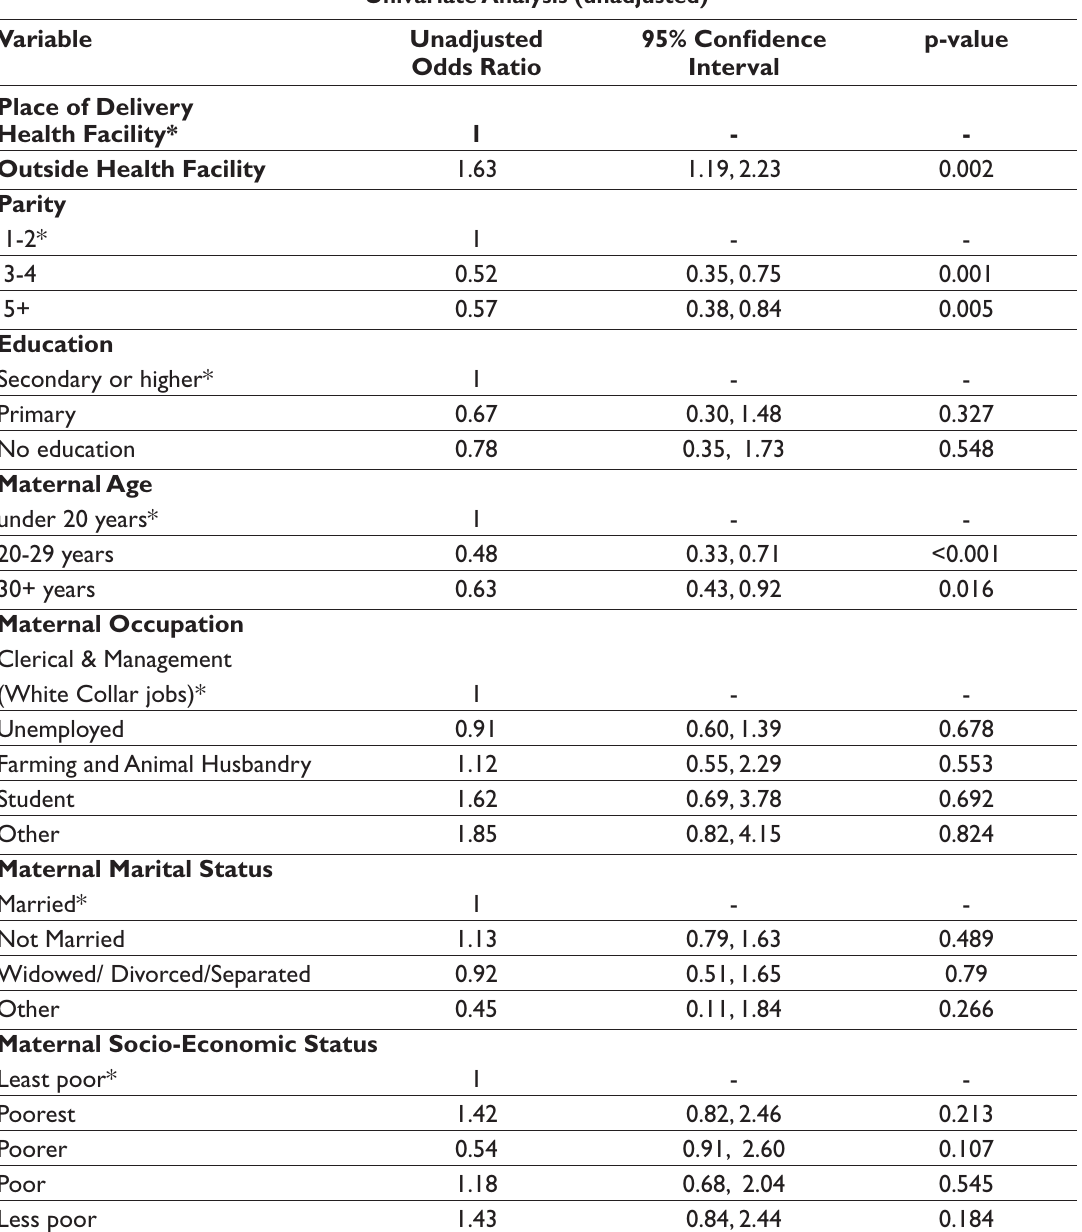
Table 3. Unadjusted Odds Ratio (OR) Estimates and 95% Confidence Intervals (CI) for Maternal Risk Factors Associated with Neonatal Mortality (Univariate Logistic Regression Analysis) Univariate Analysis